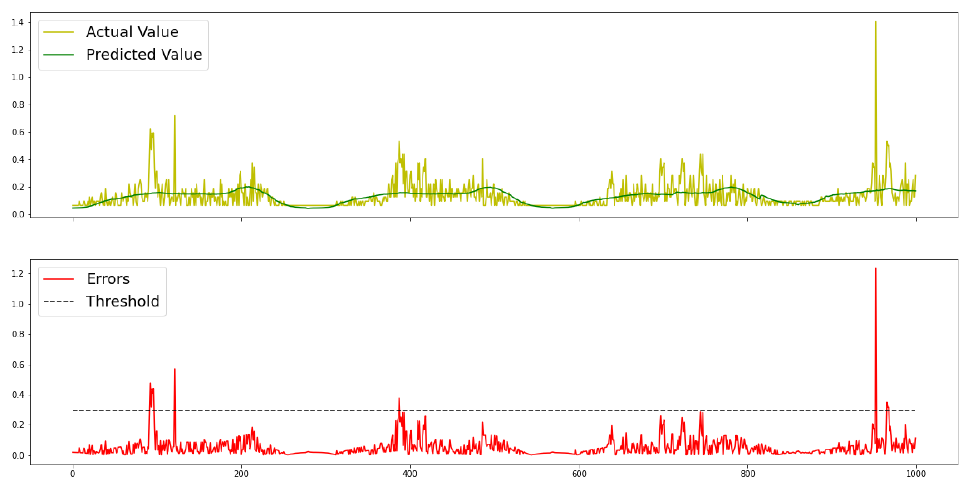
Figure 4. An example of data distribution on the sensor